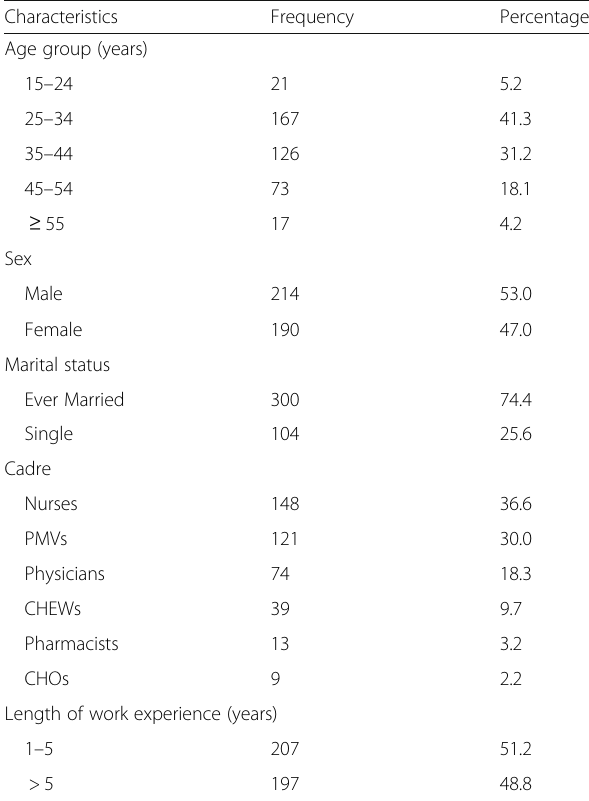
Table 1 Socio-demographic characteristics of healthcare providers, Lokoja, Nigeria ( N = 404) Characteristics